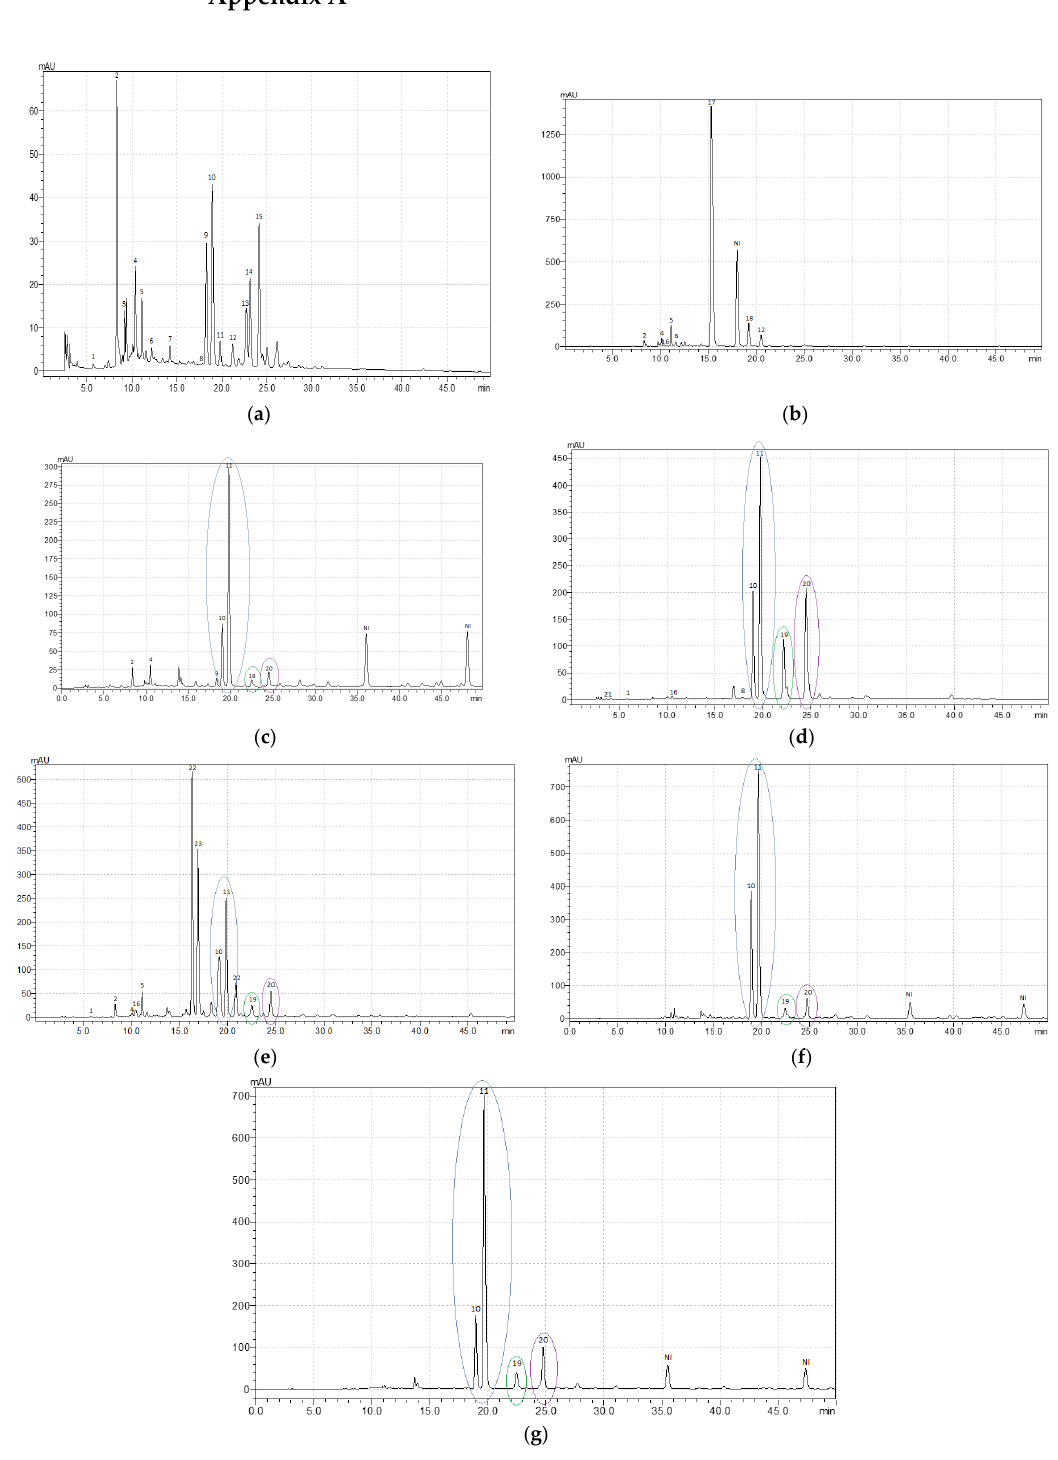
Figure A1. Chromatographic profile of the phenolic acids and flavonoids at 340 nm for ( a ) R. acetosa , ( b ) R.acetosella , ( c ) R. confertus , ( d ) R. crispus , ( e ) R. maritimus , ( f ) R. obtusifolius , ( g ) R. sanguineus : 1— protocatechuic acid; 2—sinapic acid; 3—caftaric acid; 4—chlorogenic acid; 5, 6—hydroxybenzoic acid derivatives; 7—p-coumaric acid; 8—ellagic acid; 9—quercetin derivative; 10—rutin; 11— isoquercitrin; 12 –cymaroside; 13, 14, 15—quercetin derivatives; 16—caffeic acid; 17—luteolin de- rivative; 18—apigenin derivative; 19—kaempferol derivative; 20—astragalin; 21—gallic acid; 22, 23—quercetin derivatives; 24—kaempferol derivative.